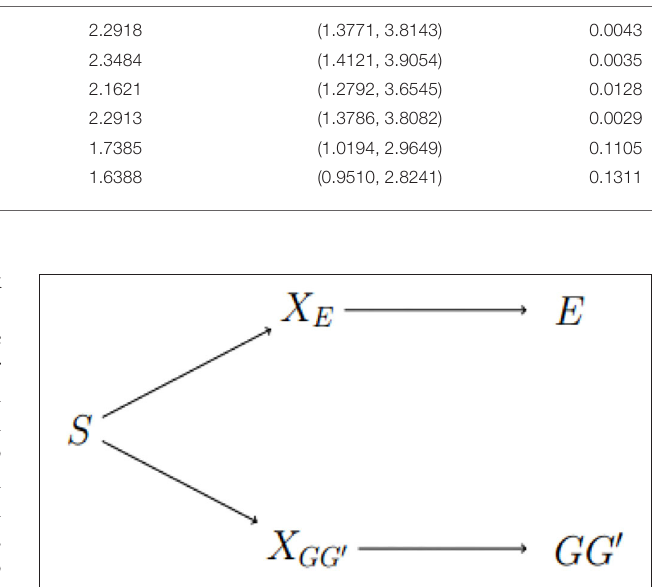
FIGURE 3 | Dependence between E and GG ′ is through latent sub-population S. Latent factors X E and X GG ′ indicate different distributions of E and GG ′ , respectively. E and GG ′ are conditionally independent given any of the three variables on the path between